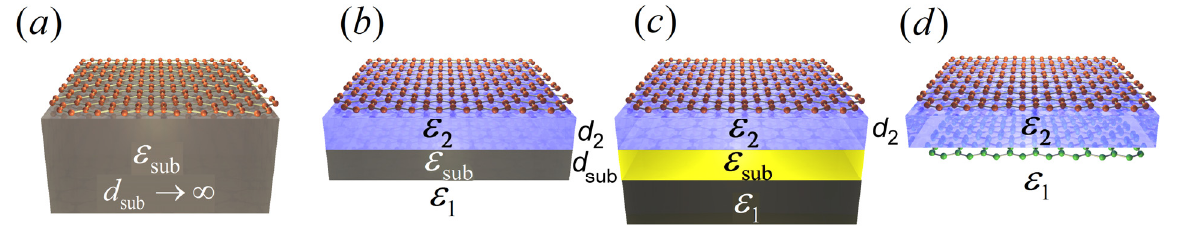
Figure 3. Structures considered in this paper: ( a ) graphene on a semi-infinite substrate of a constant permittivity; ( b ) graphene on a polar substrate; ( c ) graphene on a metal